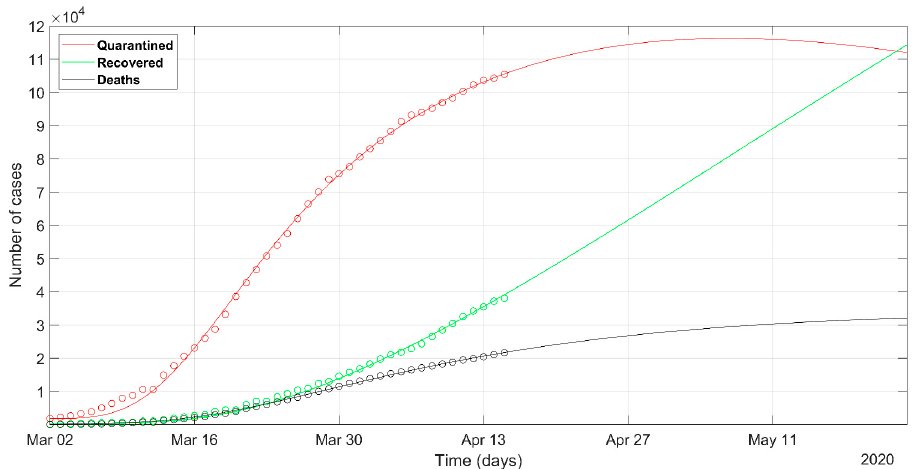
Figure 2. Observed data (circles) of quarantined (red), recovered (green), and deaths (black) for Italy, updated on 15th April 2020. The continuous lines refer to the predicted evolution in 30 days according to the SEIR model solved with the deterministic approach.